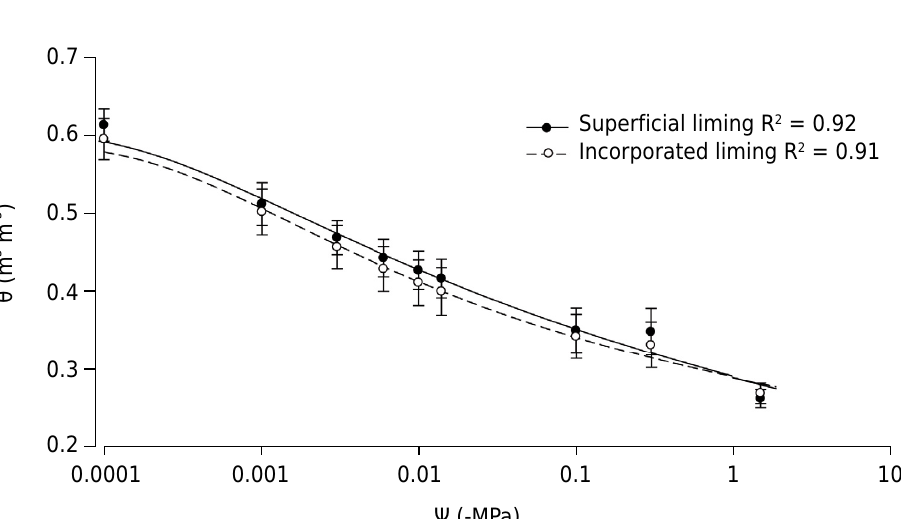
Figure 2. Soil water retention curves for surface liming and incorporated liming, estimated by the function θ = θr + {(θs – θr)/[1 + (α×Ψ) n ] 1-1/n }, where θ is the water content (m 3 m -3 ), θs is the saturated water content (m 3 m -3 ), θr is the residual water content (m 3 m -3 ), and Ψ is the soil water potential (MPa). Bars represent the mean standard deviation of θ observed at each Ψ (n =